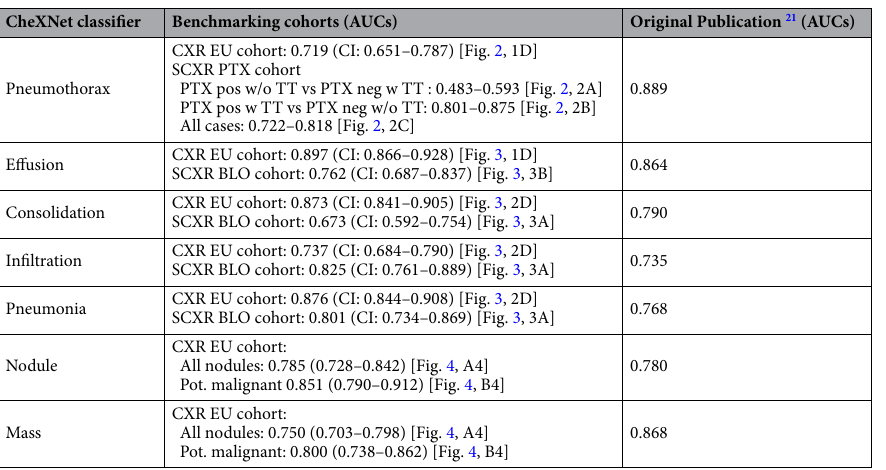
Table 3. Benchmarking performance compared to originally published performance results. The table shows a comparison of the benchmarking cohort performance results (AUCs) with 95% confidence intervals (CI) compared to the AUCs of the original publication; PTX pos (neg) w (w/o) TT: pneumothorax positive (negative) with (without) inserted thoracic tube; Pot. malignant: potentially